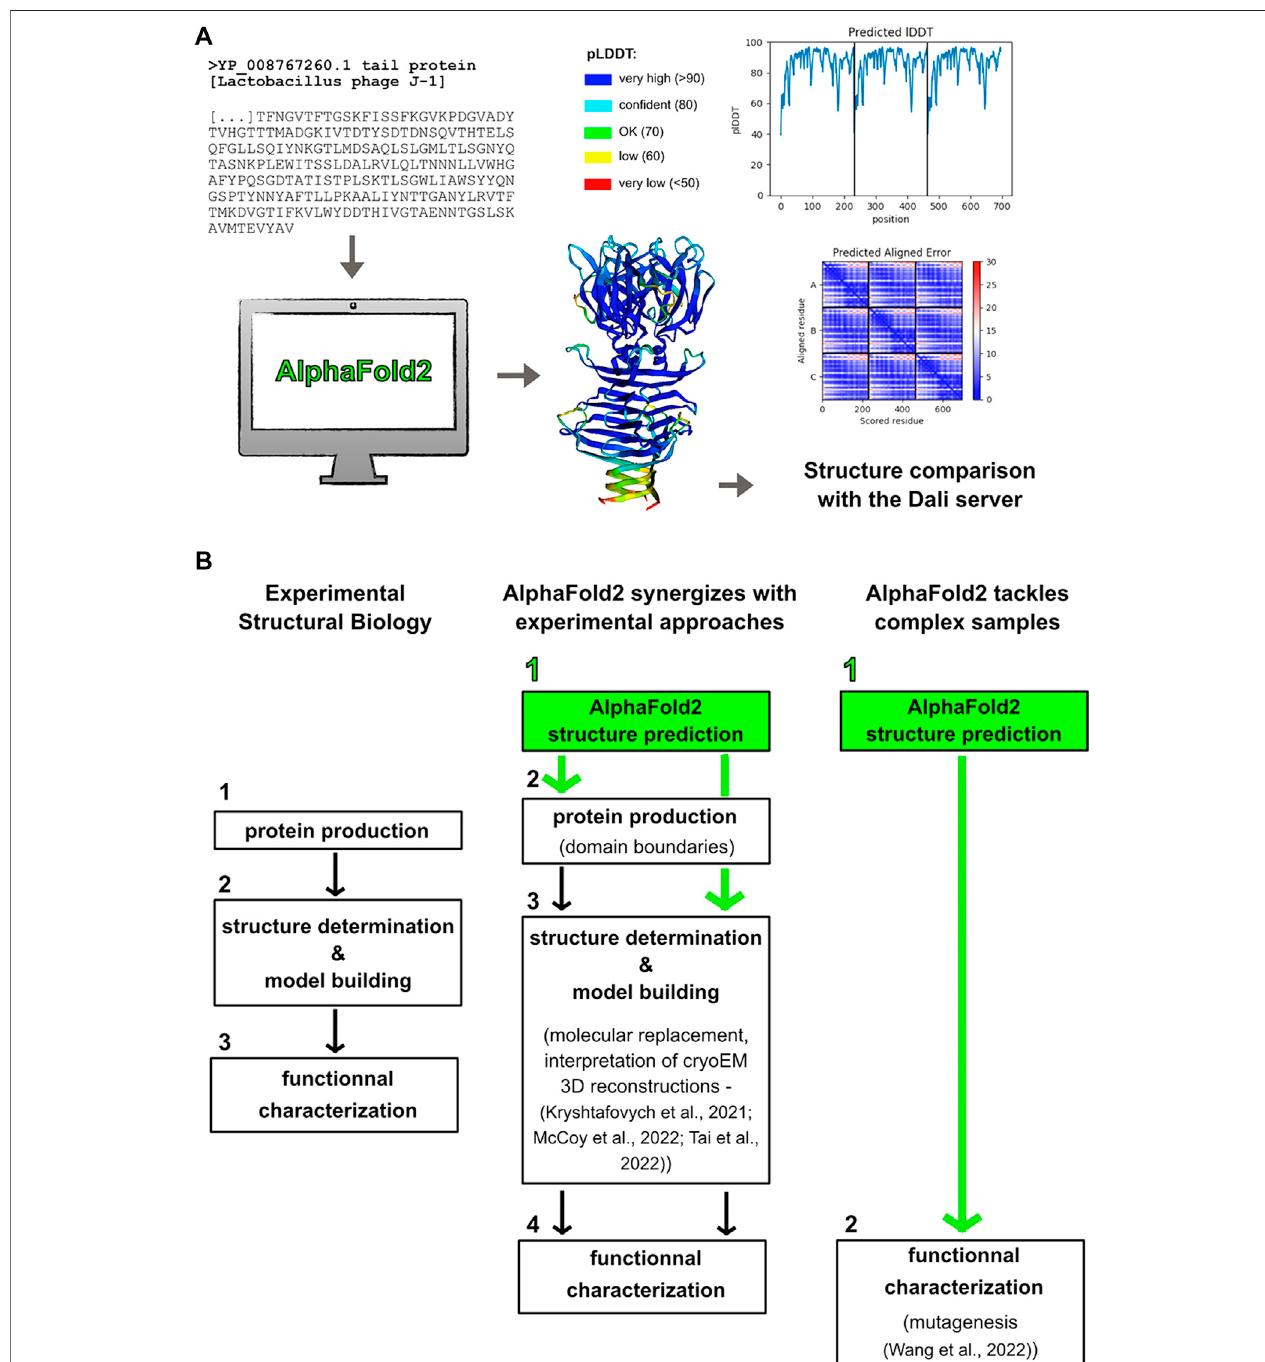
FIGURE 1 | Making the most out of Alphafold2 structure predictions. (A) Predicted structures are obtained “ simply ” by providing their sequences to the program. The pLDDT and PAE scores have to be carefully considered for structure-function analyses. Structure comparison using the Dali server may return structural homologs (Holm,2020).HereareshowntheresultsobtainedfortheTalC-terminaldomain(trimericassembly)fromthe L.casei phageJ-1. (B) AlphaFold2isbecominganessential part of any structural biology project. AlphaFold2 can synergize with experimental approaches in that predicted structures can be used to determine domain boundariesforrecombinantproteinproduction,tosolvecrystalstructuresbymolecularreplacement,andtointerpretcryoEM3Dreconstructions.Moreover,AlphaFold2 can be the only way to get structural models of challenging samples, which can then be used as reliable templates for functional characterization.